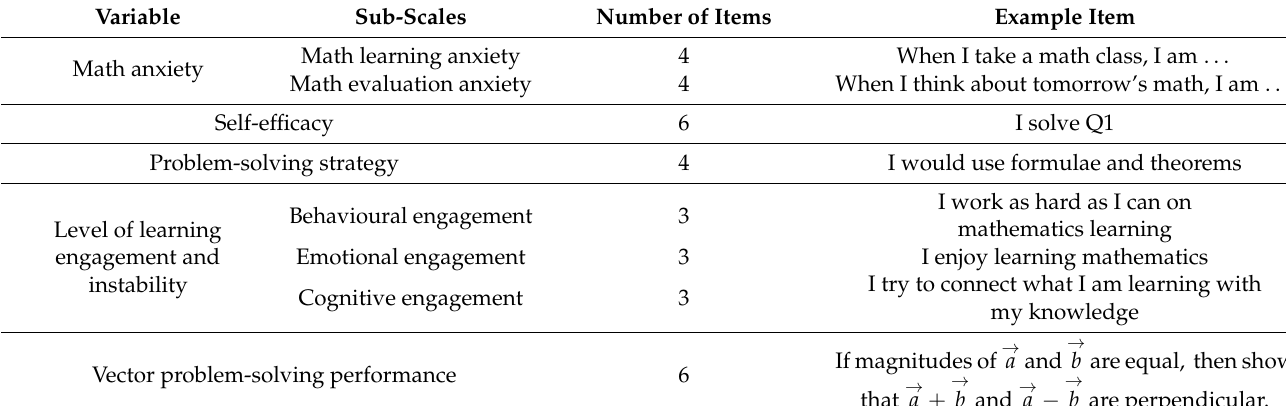
Table 1. Summary of measures used in this